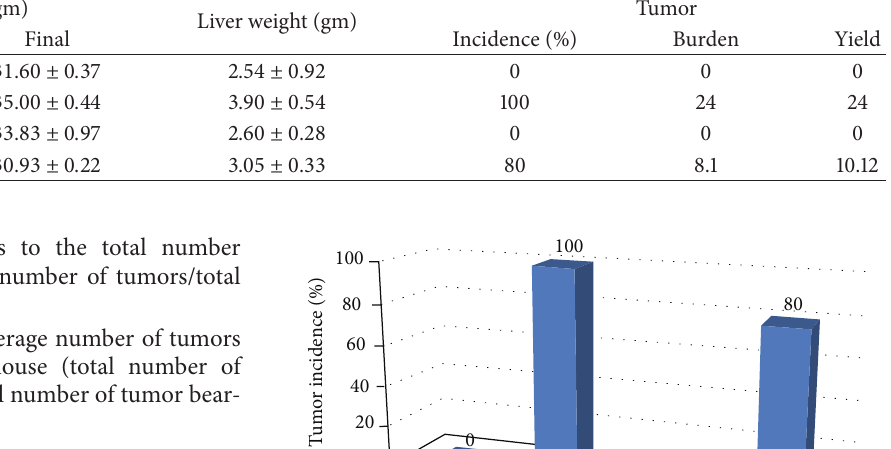
Table1:Variationsinbodyweight,liverweight,andmorphometryoflivertumorafterDENA/CCl Group